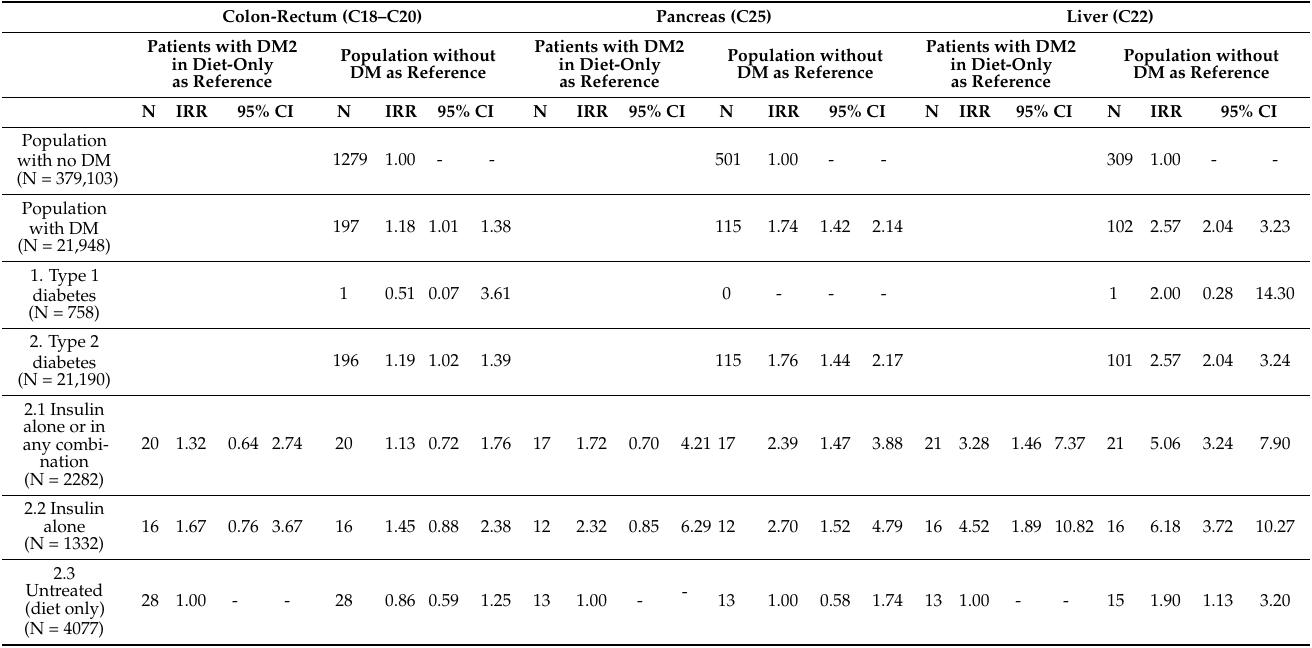
Table 3. Number, incidence rates ratios (IRR), and 95% confidence intervals (95% CI) of colorectal, pancreatic, liver, trachea, bronchus and lung cancer, stomach cancer and lymphoma, corpus uteri, breast (women only), ovary, kidney, bladder, and prostate cancer by type of treatment with type 1 and type 2 diabetes (DM1; DM2). Reggio Emilia 2011-16, resident population aged 20–84 years. See Supplementary Material Table S6 for “other sites”.